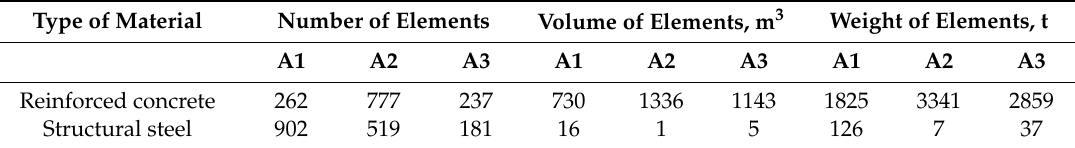
Table 4. Physical parameters of alternative structural